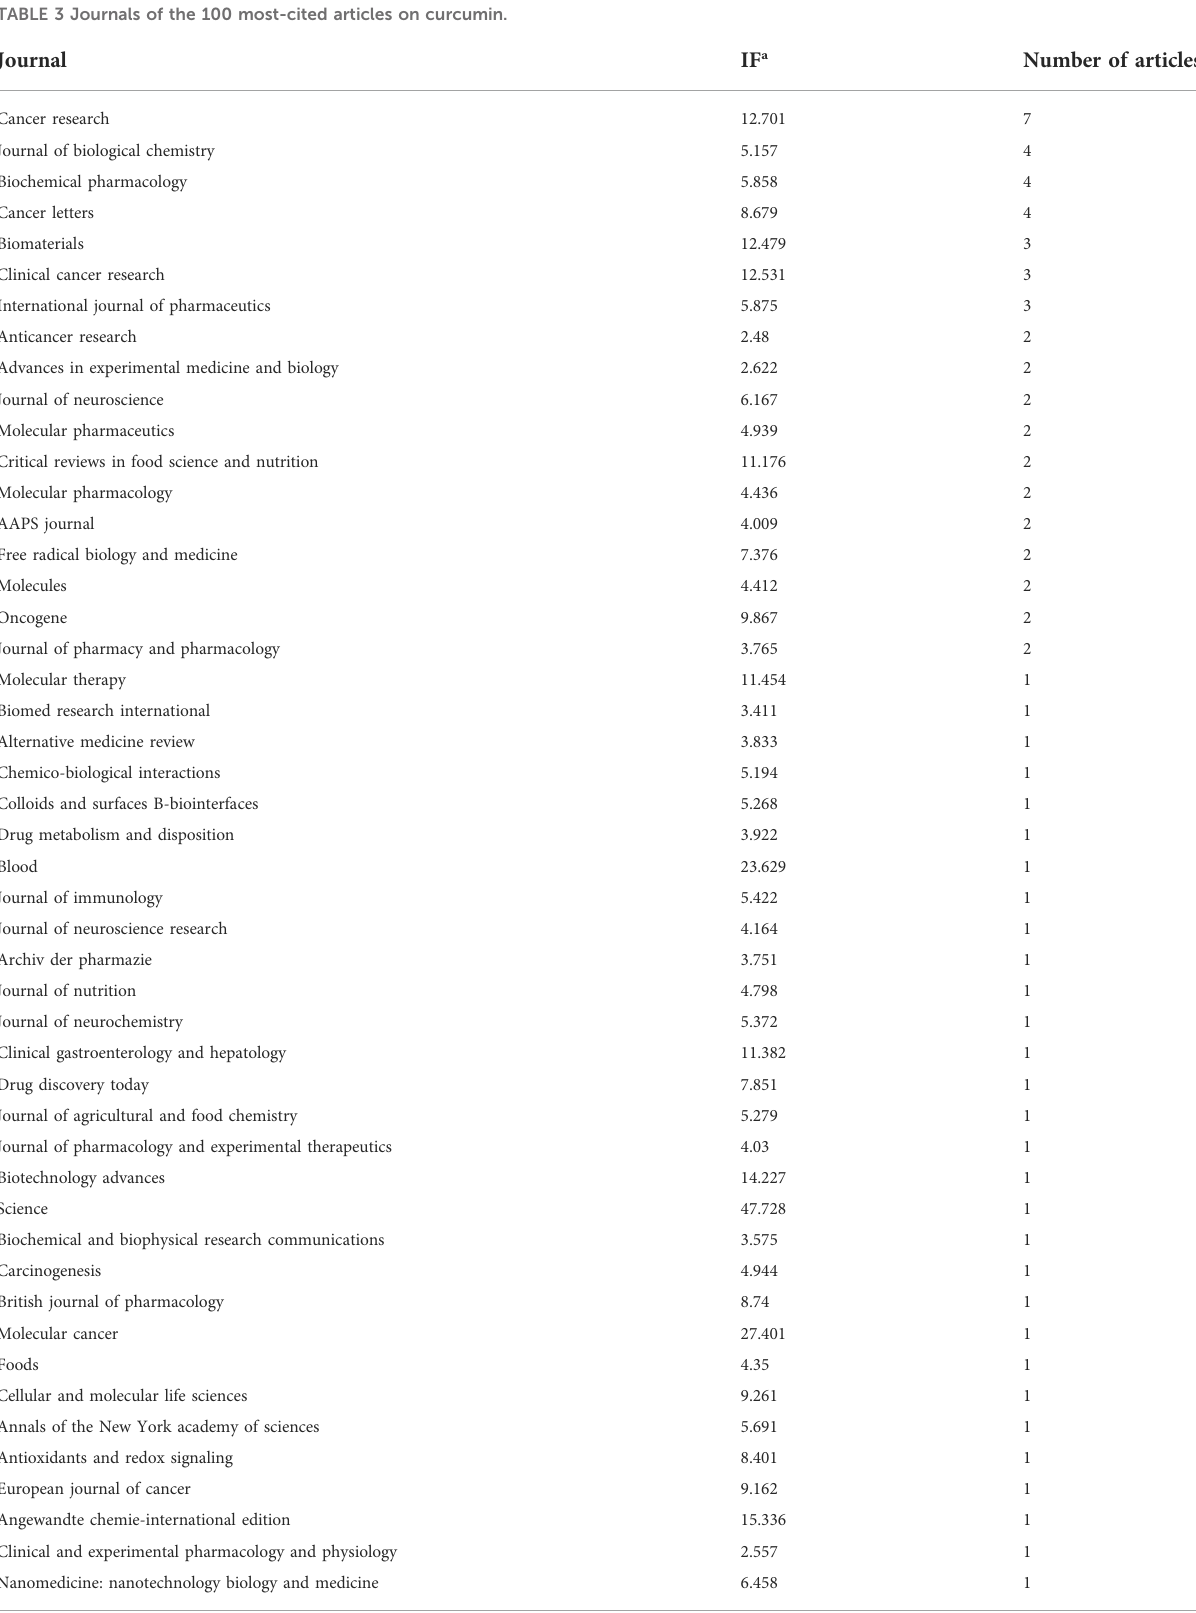
TABLE 3 Journals of the 100 most-cited articles on